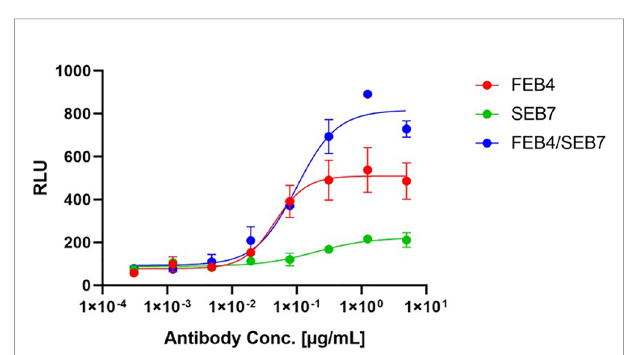
FIGURE 6 | ADCC Assay of parental and biparatopic antibodies on A431 cells. The Promega ADCC assay was performed utilizing the parental and the biparatopic variants. 12,500 A431 cells were cultured overnight before incubation with a fourfold serial dilution of antibodies (5 µg/ml to 305 pg/ml) and ADCC effector cells for 6 h. Luciferase signal is plotted against the logarithmic antibody concentration. EC 50 values: FEB4, 45.8 pM; SEB7, 191.5 pM; FEB4/SEB7, 98.9